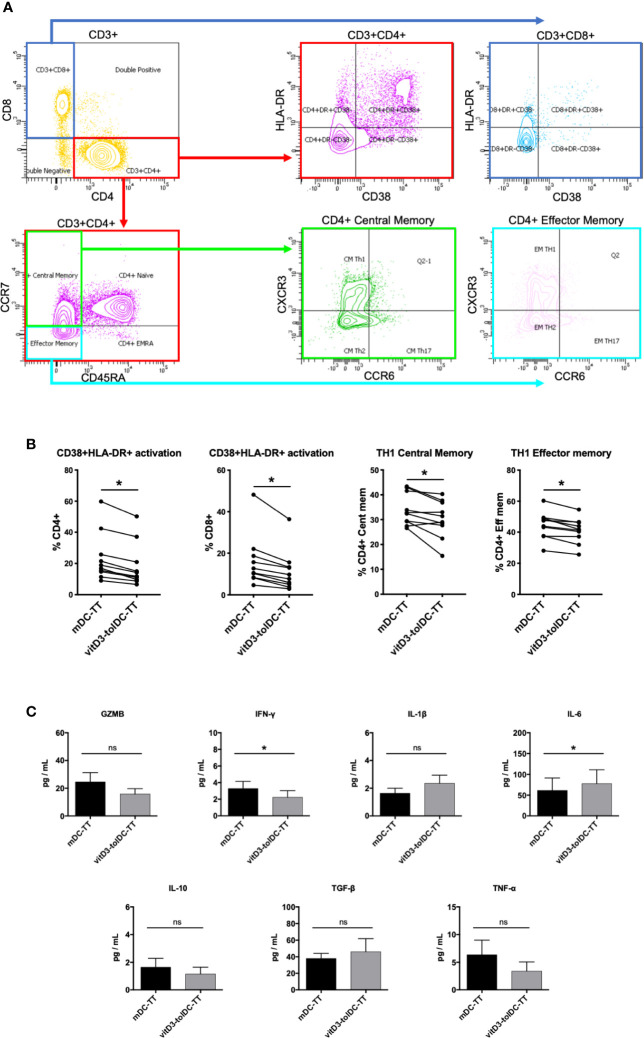
Phenotype and cytokine production of DC-co-cultured autologous PBMC. (A) Gating strategy. (B) Relative percentages of CD4+CD38+HLA-DR+, CD8+CD38+HLA-DR+, TH1 Central Memory and TH1 Effector Memory subpopulations on PBMC co-cultured with either tetanus toxin (TT)-loaded mature DC (mDC-TT) or TT-loaded vitamin D3-induced tolerogenic DC (vitD3-tolDC-TT) after 5 days of culture (n = 10). Data presented as the relative percentage of each lymphocyte subpopulation within its respective parent subpopulation, measured by multiparametric flow cytometry, in a box and whiskers representation. Error bars corresponding to the maximum and minimum values of each condition. (C) Analysis of the secretion of granzyme B (GZMB) (n = 12), IFN-γ (n = 12), IL-1β (n = 8), IL-6 (n = 8), IL-10 (n = 10), TGF-β (n = 7), and TNF-α (n = 8) in the supernatants of PBMC co-cultured with either mDC-TT or vitD3-tolDC-TT after 5 days of culture using either ELISA (TGF-β) or cytometric bead array (GZMB, IFN-γ, IL-1β, IL-6, IL-10, and TNF-α) techniques. One ELISA experiment was performed for all samples, with duplicated measurements for each sample. One single cytometric bead array experiment was performed for the analysis of all the samples, with one single measurement for each sample. Sample sizes vary due to some measurements being negative or under the detection limit of the technique. Error bars corresponding to SEM. ns, not significant; * p < 0.05. Paired t test or Wilcoxon test.